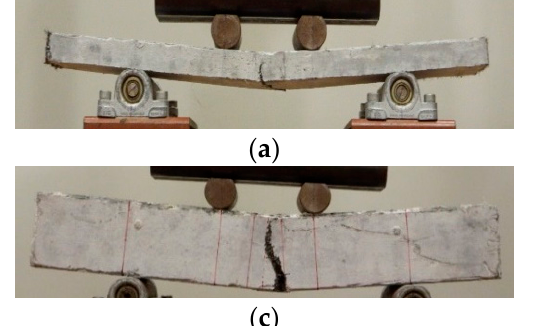
Figure 3. Experimental setup for the testing of (a) UHPFRC-1 and (b) UHPFRC-2 beams. The typical failure in all the examined cases was formed with a main crack in the middle of the span. The crack patterns for selected typical prisms with different depths are presented in Figure 4. The load-deflection results for all the examined specimens for UHPFRC- 1 and UHPFRC-2 are presented in Figure 5a,b, respectively.